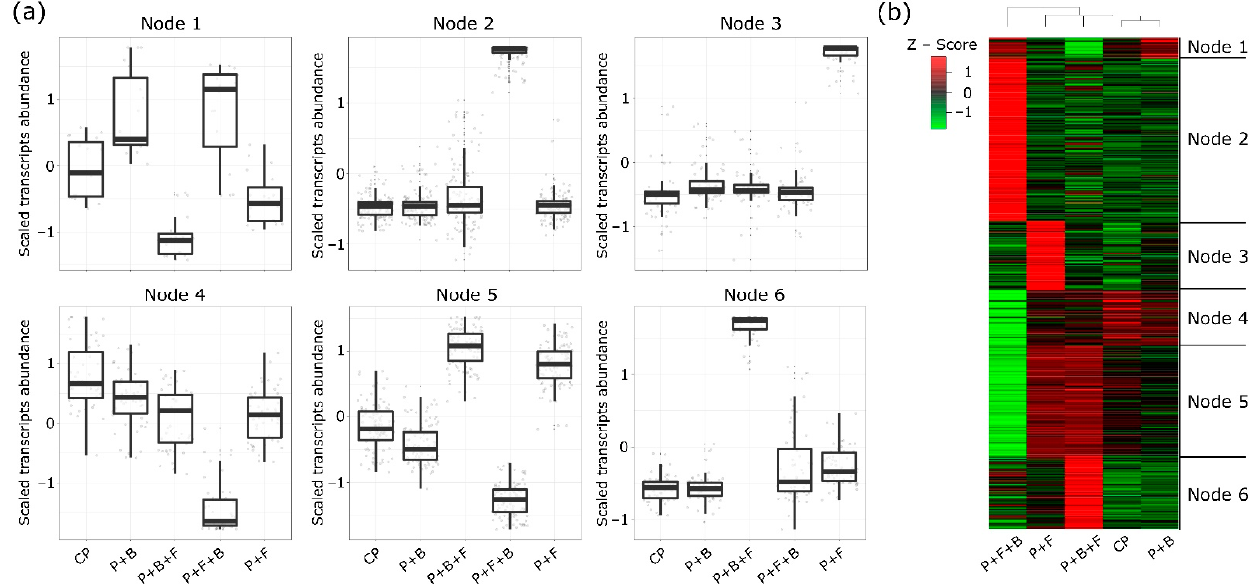
Figure 3. Differential gene expression (DGE) analysis by self-organizing map (SOM) and heat map. ( a ) SOM analysis with six nodes representing unique gene expression patterns in each treatment. In the box plots, lines and horizontal bars represent median, minimum and maximum of gene expression values, respectively. ( b ) Heat map developed from DGE analysis of gene expression of the four treatments, including SOM clustering